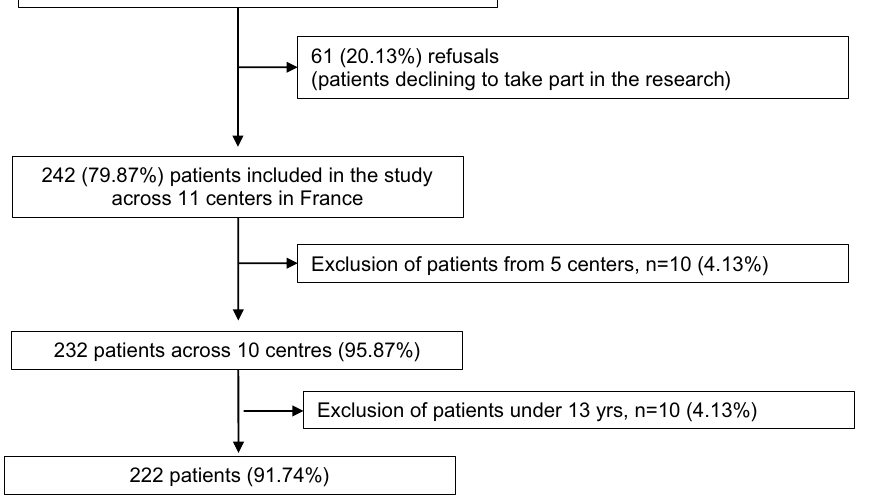
Figure 1. Flow diagram of number of patients included in the present